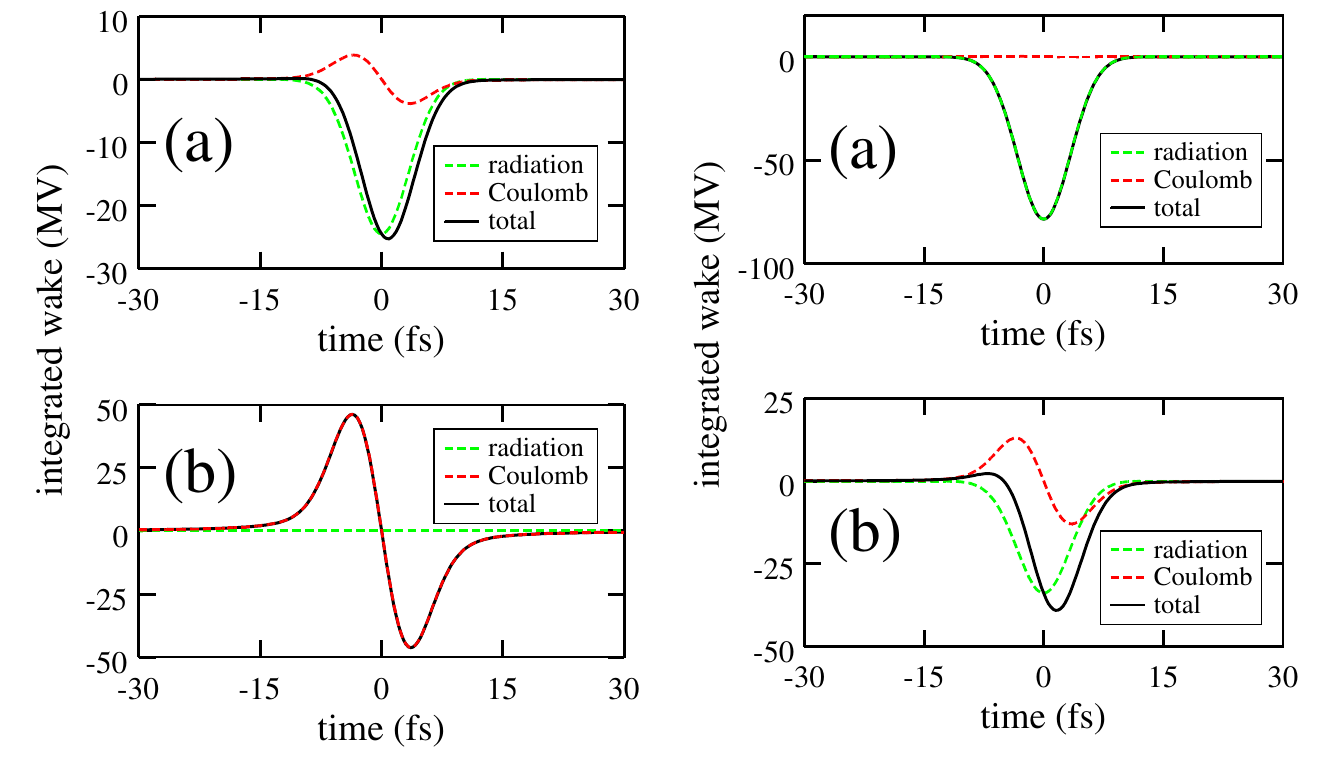
FIG. 4. (Color) The integrated coherent-radiation wake, FIG. 3. (Color) The integrated coherent-radiation wake, Coulomb wake, and total wake for a bunch emitted from plasma Coulomb wake, and total wake for a bunch emitted from plasma (cid:6) (cid:7) (cid:6) 1 (cid:9) m , peak current of 160 kA, and energy of with r b z (cid:6) (cid:7) (cid:6) 1 (cid:9) m , peak current of 50 kA, and energy of with r b z 1.74 GeV. Here, a negative wake corresponds to energy loss; a 150 MeV. Here, a negative wake corresponds to energy loss; a positive time describes the tail of the bunch. (a) Integrated wakes positive time describes the tail of the bunch. (a) Integrated wakes at z (cid:6) 3 cm . (b) Integrated wakes through an undulator of length at z (cid:6) 3 cm . (b) Integrated wakes through an undulator of length (cid:6) 30 (cid:9) m . 5 m, where the bunch radius is r b (cid:6) 30 (cid:9) m 0.8 m, where the bunch radius is r b